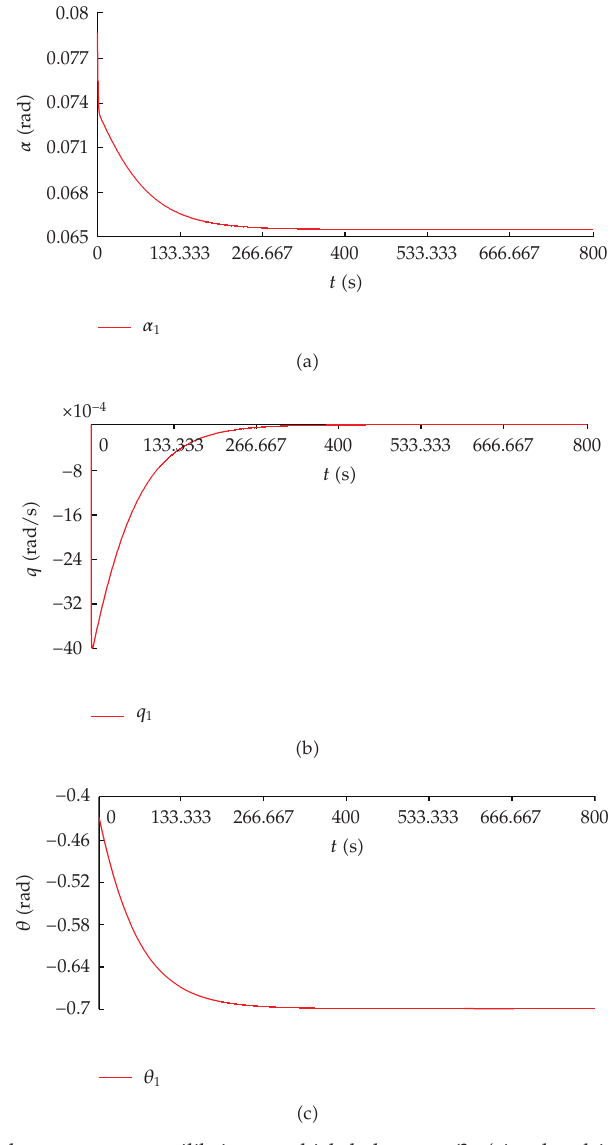
(cid:7) 0 . 03026 (cid:5) rad (cid:6) (cid:7) 1 . 734 ◦ . α (cid:6) e (cid:7) 0 . 065516 (cid:5) rad (cid:6) (cid:7) 3 . 755 ◦ ; q (cid:6)(cid:6) 1